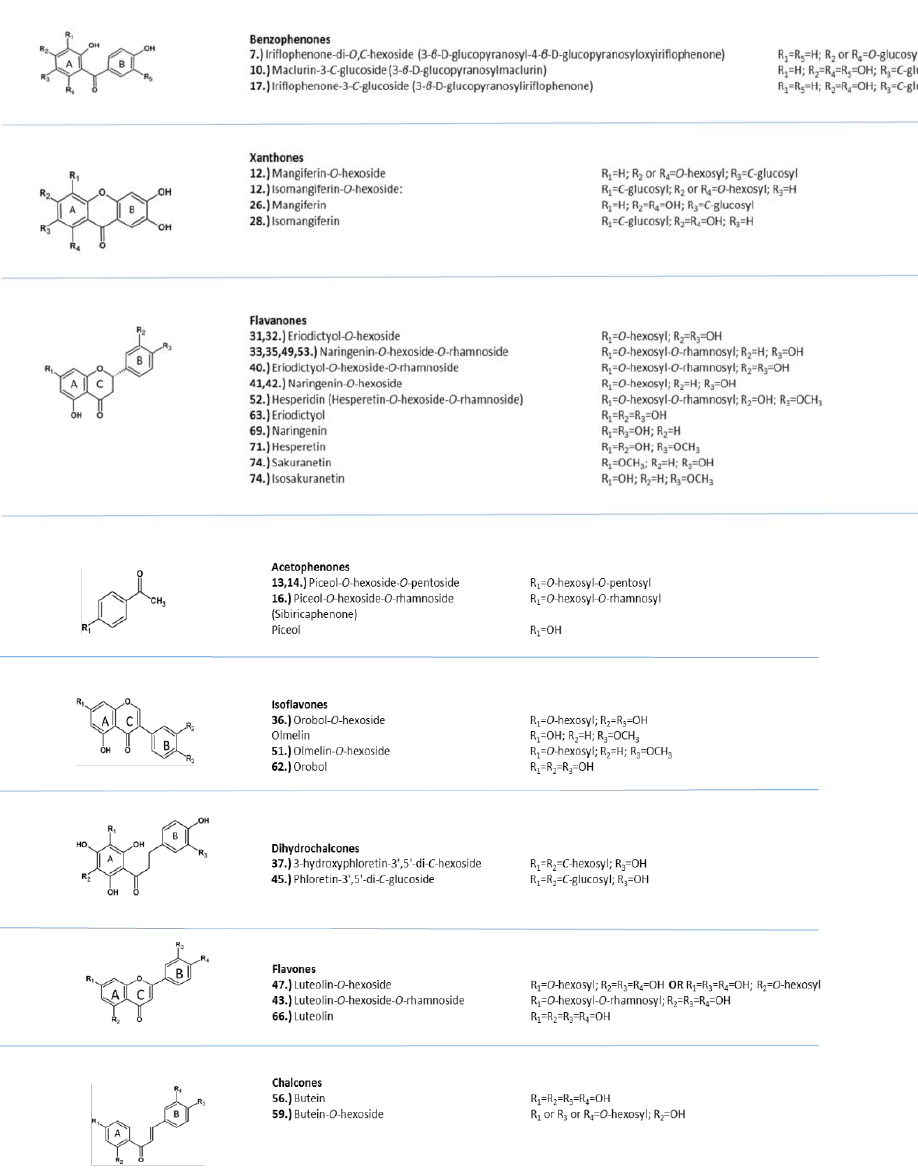
Figure 4. Selected structures of the compounds detected in Cyclopia extracts, numbered according to to Table Table 1.